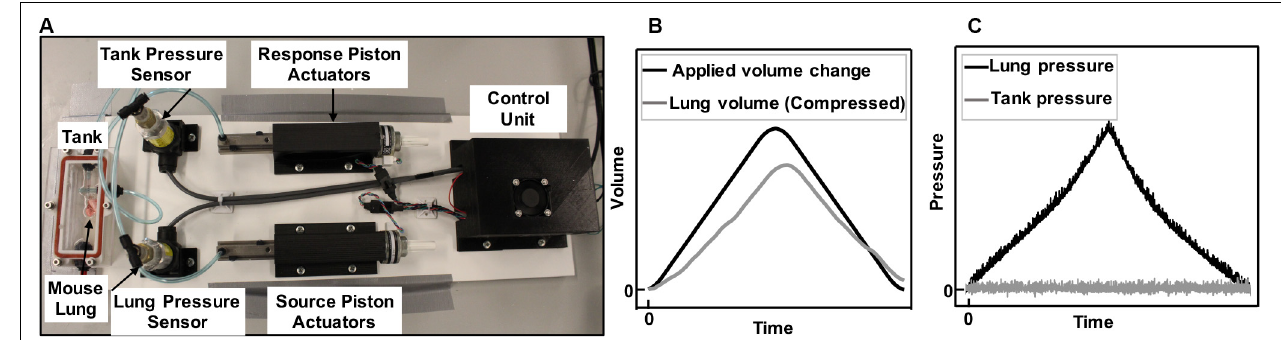
FIGURE 1 | Experimental device capable of inflating and deflating the whole lung (A) . Components included airtight, transparent tank, control unit, and tubing connecting the lung placed inside the tank to the source piston and actuator, as well as the outlet of the tank to the response piston and actuator. Positive-pressure ventilation representative plots of applied and recorded volume change to a mouse lung (B) and the resulting rise in lung pressure and controlled zero change tank pressure (C) is shown. Air was pushed inside the lungs ( B , black line) and the lung pressure rises ( C , black line). As the lungs expanded in the tank, they caused a rise in the tank pressure due to decreased available tank space. The tank response piston, which recorded the pressure in real time, moved to make more volume available in the tank and maintain atmospheric pressure ( C , gray line). The change in volume of the lung was therefore recorded through the response piston actuator’s motion, enabling the recording of the lung’s compressed air volume in real time ( B , gray